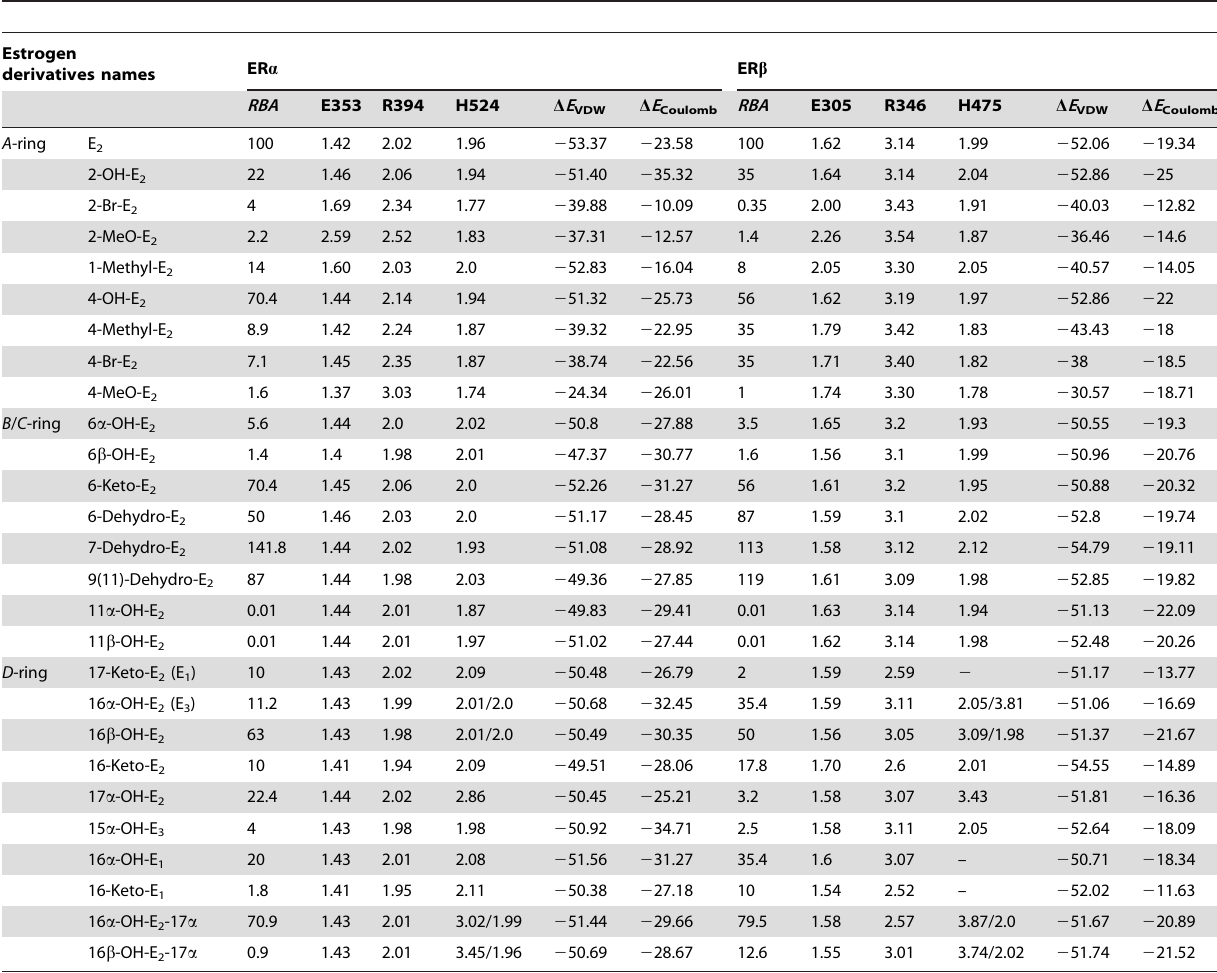
Table 1. Hydrogen bond lengths (A˚) and calculated van der Waals interaction energy ( D E VDW , kcal/mol) and Coulomb interaction energy ( D E Coulomb , kcal/mol) between estrogen derivatives and the ER a and ER b LBDs.